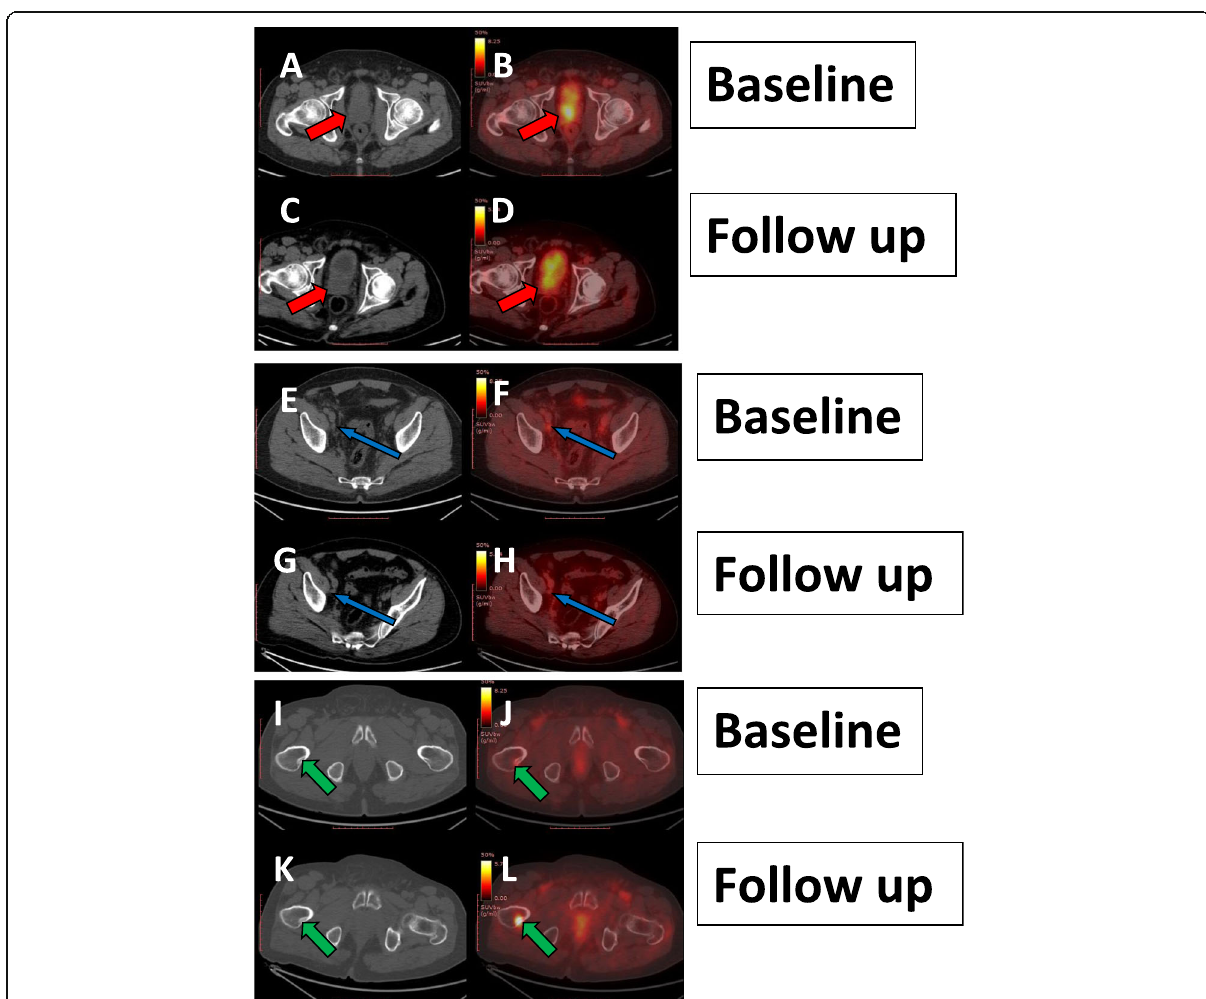
Fig. 1 Axial non-contrast CT and PET-CT images for a 62-year-old male patient with history of prostate cancer for which he had chemotherapy and radiotherapy. Images a and b (baseline study) showed focal prostatic 68Ga-PSMA activity with SUVmax = 9.2 denoting residual neoplastic lesion that showed activity regression in images c and d (follow up study) showing SUVmax = 3.4 (red arrows). Images e and f (baseline study) showed metastatic low-grade 68Ga-PSMA activity by subcentimetric right external iliac lymph node with SUVmax = 3.5 and showed activity regression in images g and h (follow up study) with SUVmax = 1.7 (blue arrows). Images i and j (baseline study) showed small right femoral neck sclerotic lesion with minimal 68Ga-PSMA activity that was considered insignificant, yet it showed activity progression in images k and l (follow up study) with SUVmax = 9.6 (green